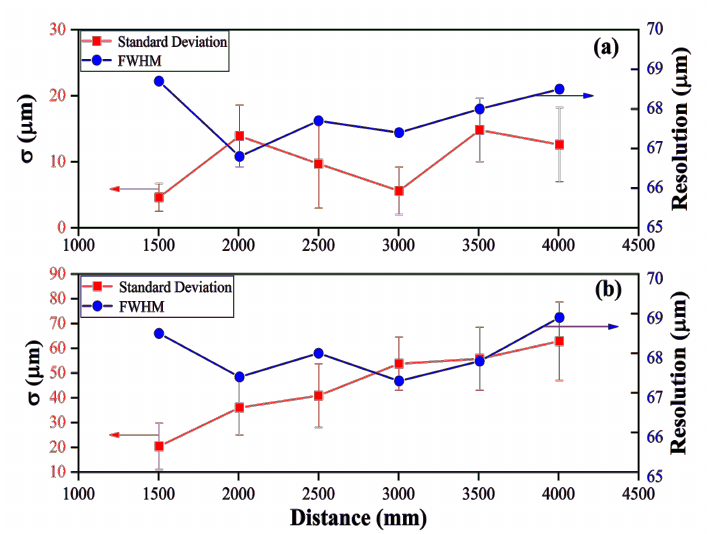
Figure 8. Resolution and standard deviation of different absolute distance measurement, ( a ) different absolute distance measurement results with HT subdivision method, ( b ) different absolute distance measurement results with peak-valley resampling